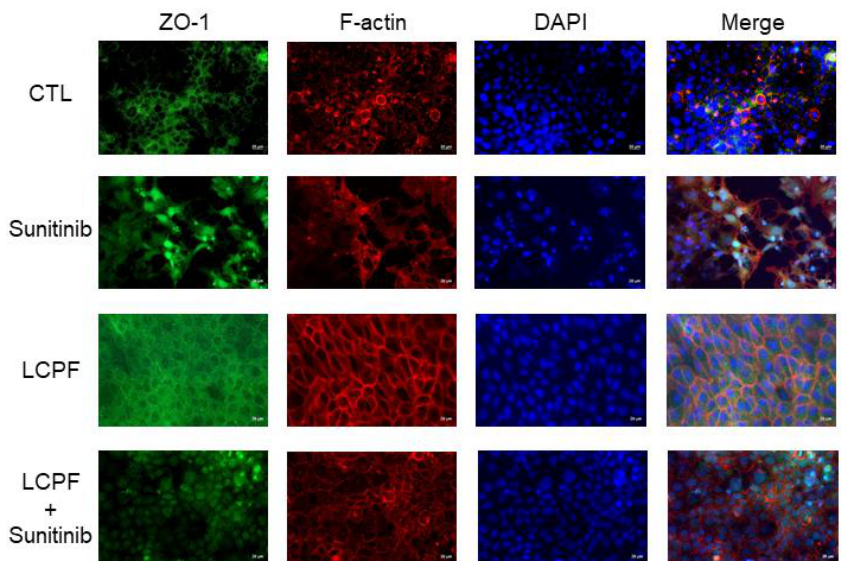
Figure 7. Abrogation of LCPF-induced epidermal junction rearrangement via VEGFR2 inhibitor. HaCaT cells were treated with or without 10 µM of sunitinib (Sun), applied as a VEGFR2 inhibitor, in the presence of LCPF for 24 h. Cells were then subjected to staining for ZO-1 (green), F-actin (red), and DAPI (blue). Scale bar = 40 mm.